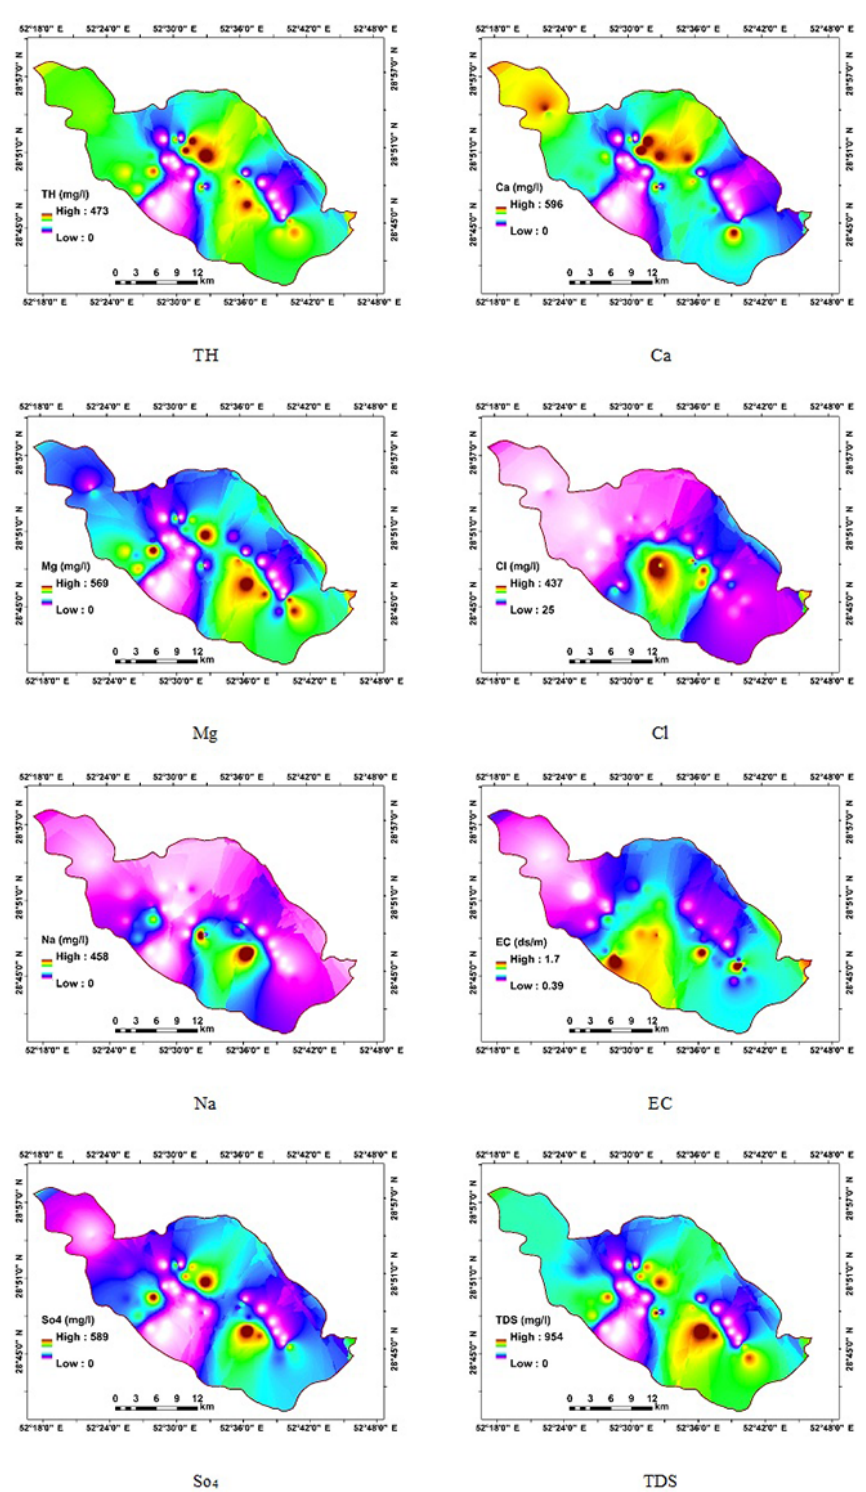
Figure 5. Interpolated maps of the drinking water quality based on the content of inorganic component parameters generated by using OK.